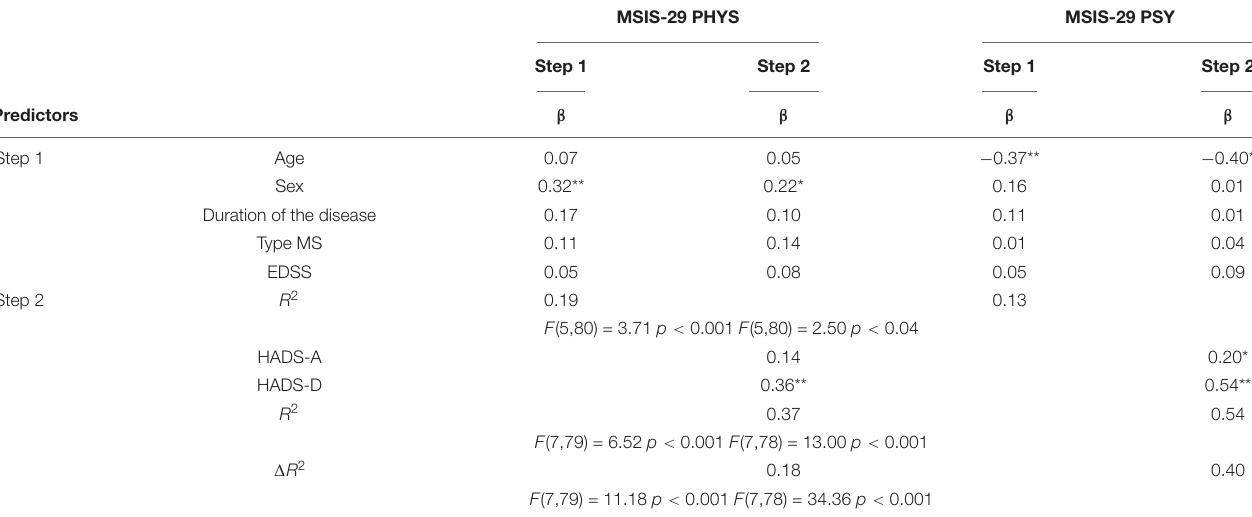
TABLE 7 | Multiple hierarchical regression analyses for the incremental validity of HADS and relevant variables on MSIS-29